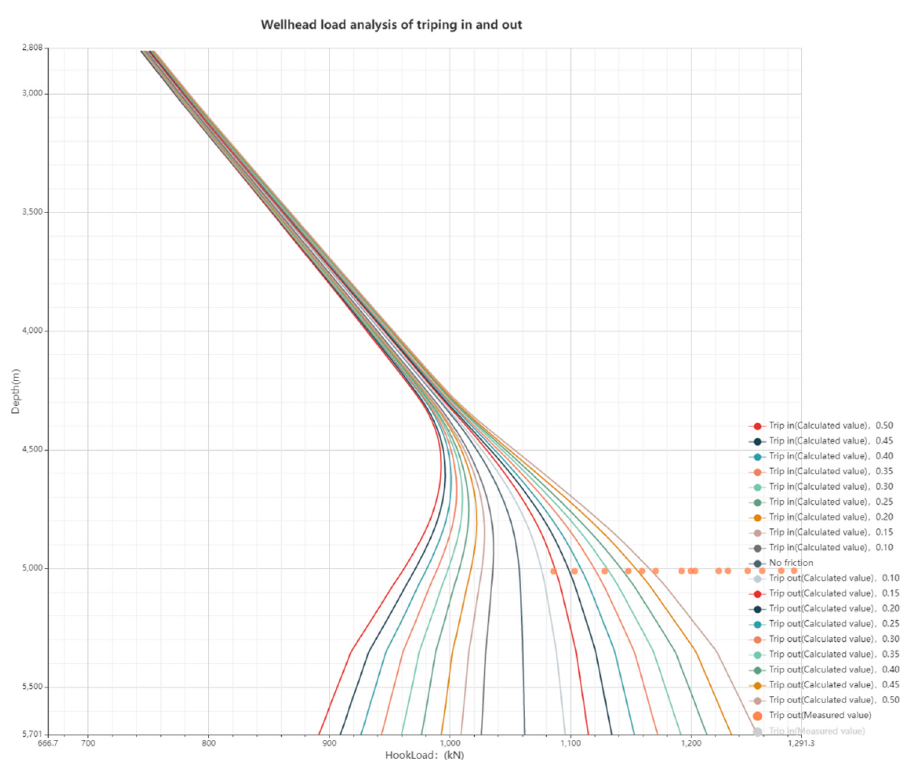
Figure 10. The deviation of the measured POOH hookload value after stuck for well N.